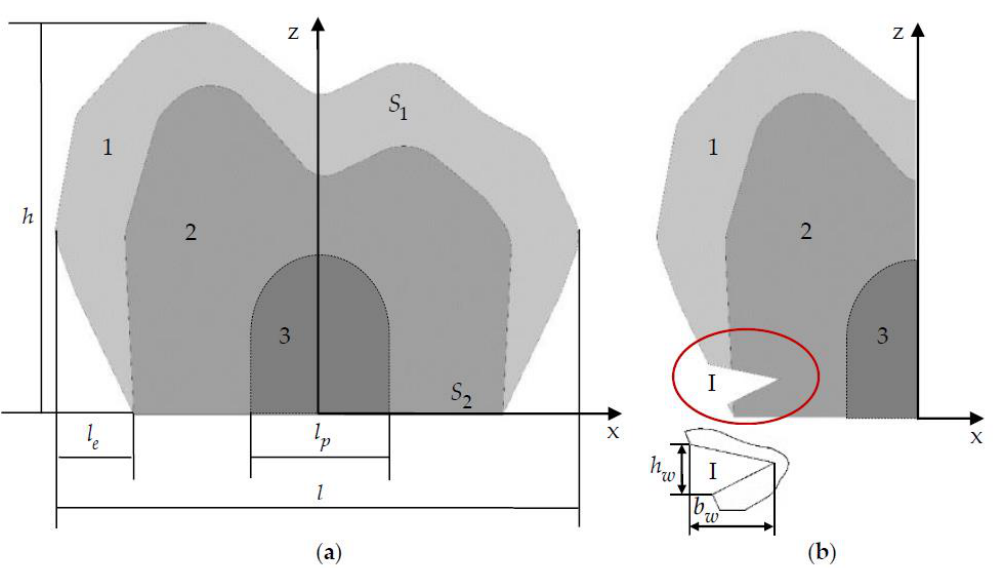
Figure 1. The central section of the tooth, taking into account ( a ) and without taking into account ( b ) an NCCL: 1 is enamel; 2 is dentine; 3 is pulp; I is defect. ( b ) an NCCL: 1 is enamel; 2 is dentine; 3 is pulp; I is